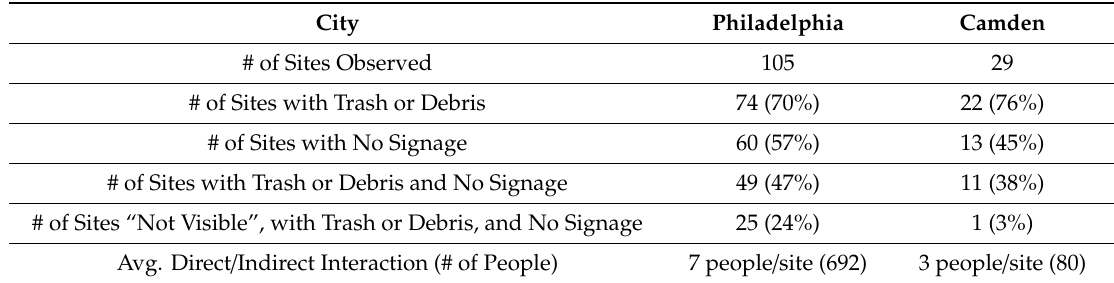
Table 4. Trash, Signage, and People in or Around GSI